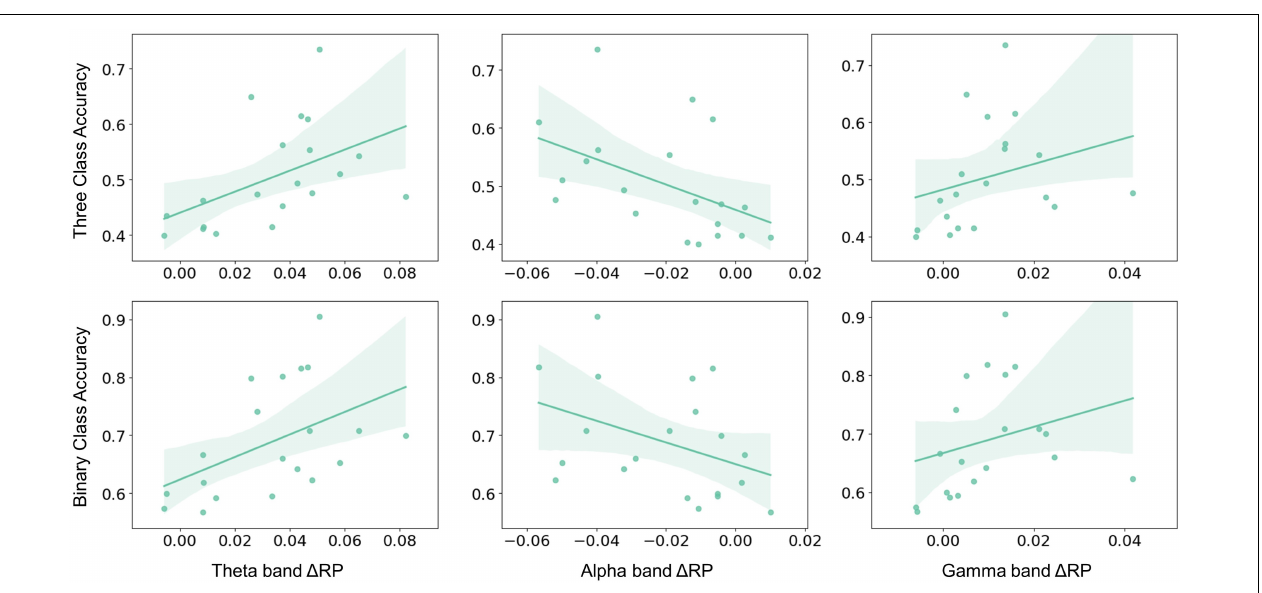
FIGURE 5 | The Spearman–rank correlation between (cid:49) RP and performance across subjects. Alpha band (cid:49) RP was negatively correlated with three-class classification accuracy ( r = –0.564, p = 0.01) and binary-class classification accuracy ( r = –0.431, p = 0.058). Whereas theta and gamma band (cid:49) RP were positively correlated with three-class classification accuracy (theta: r = 0.615, p < 0.01; gamma: r = 0.549, p < 0.05) and binary classification accuracy (theta: r = 0.54, p < 0.05; gamma: r = 0.528, p <